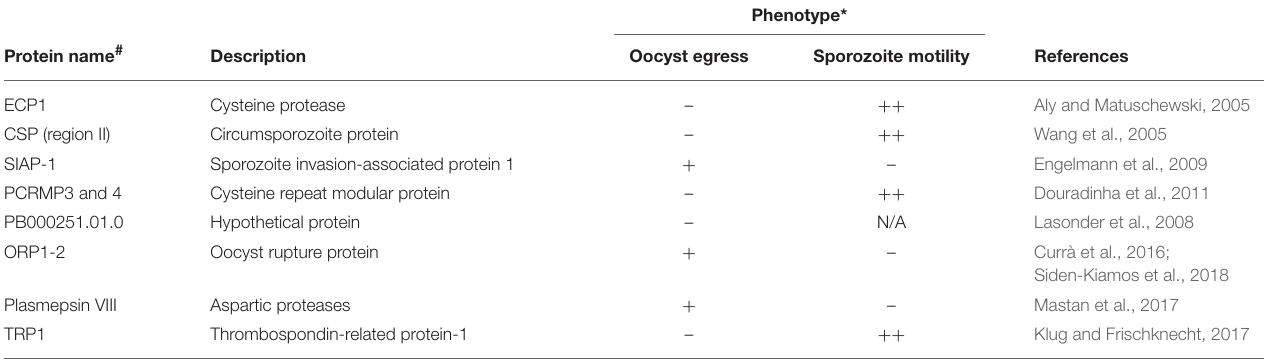
TABLE 1 | Known/suspected factors involved in Plasmodium oocyst